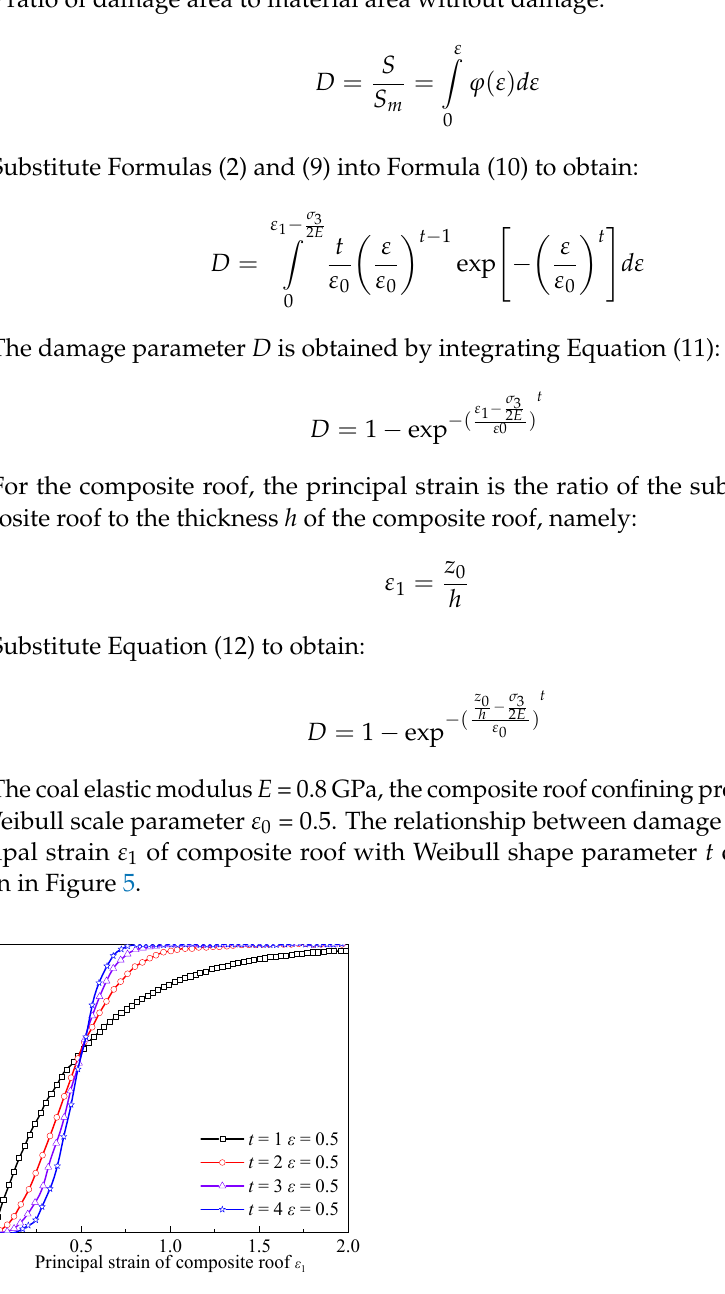
Figure 5. Relationship between damage parameters and principal strain of composite roof under different Weibull shape parameters.